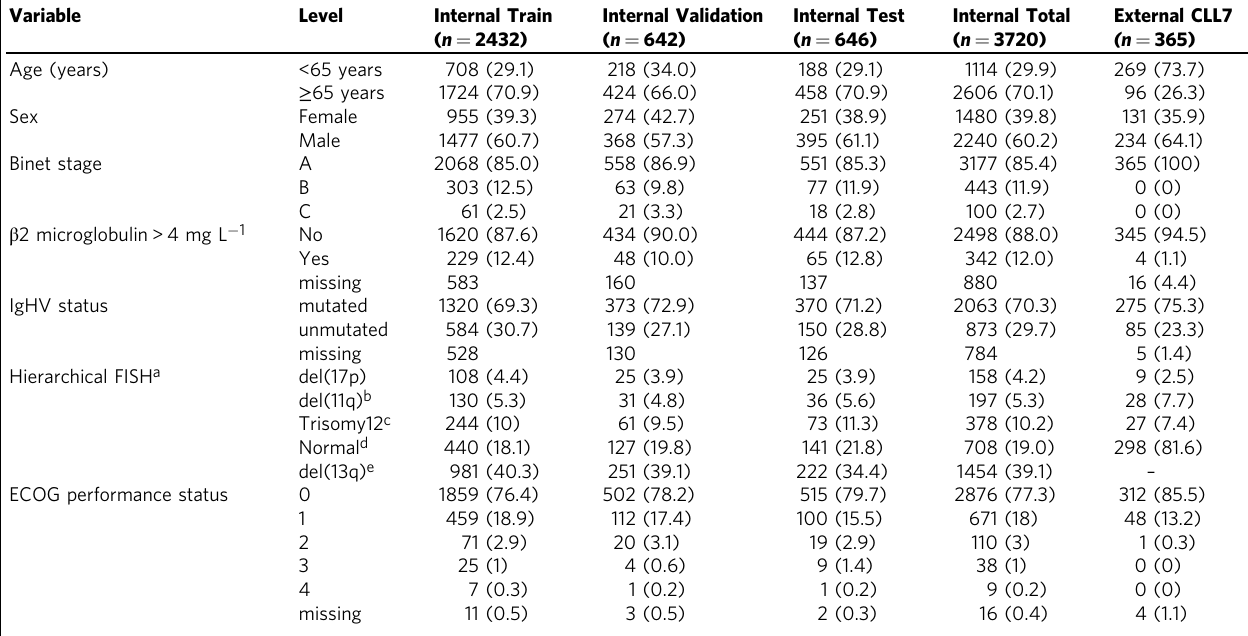
Table 1 Baseline characteristics internal and external cohorts.